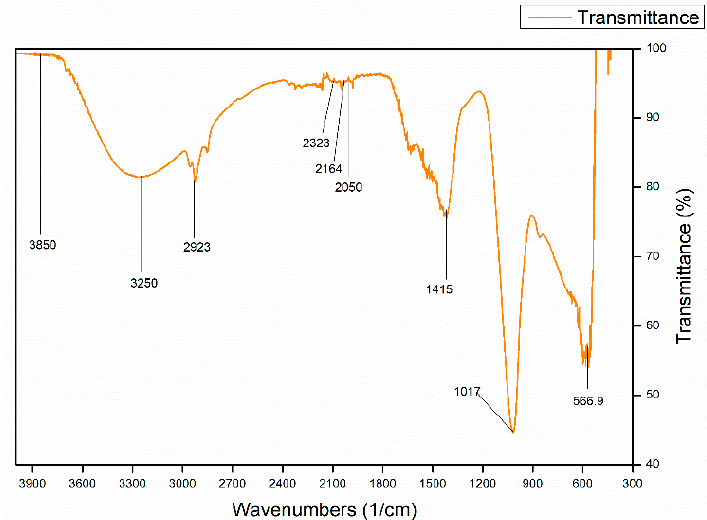
Figure 4. FTIR peaks for the extracted polymer within the transmittance range of 400–4000 cm − 1 . The labels indicate the peaks through which functional groups are analyzed and compared with the peaks of the standard polymer, in this case, PHB.